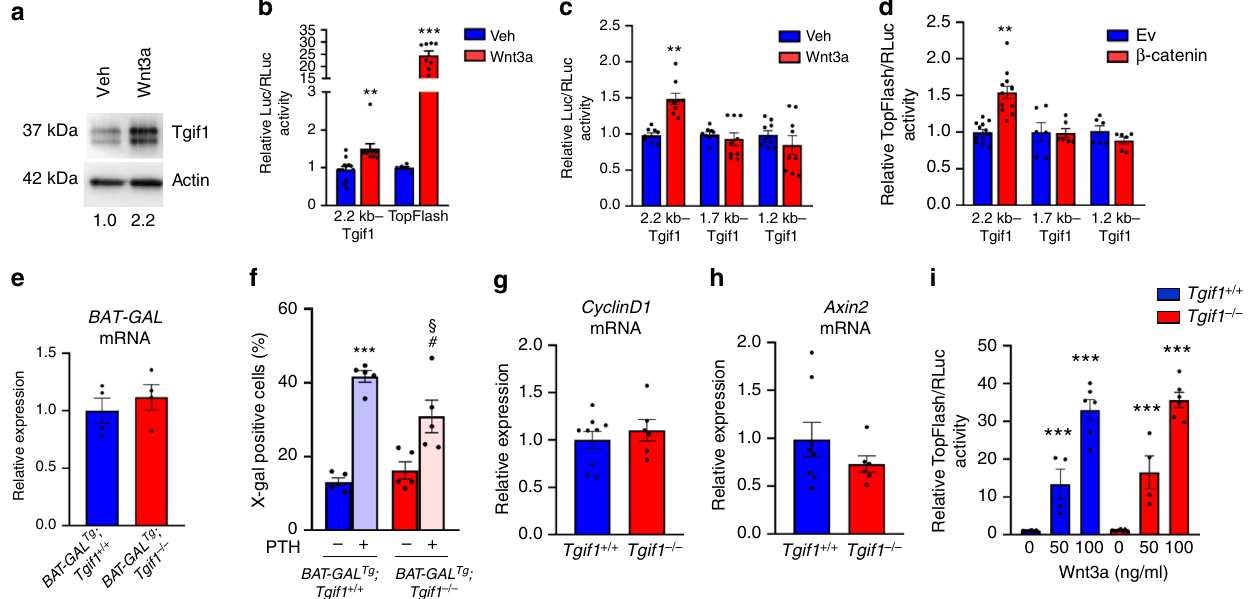
Fig. 3 Deletion of TG-interacting factor 1 (Tgif1) does not alter canonical Wnt signaling. a Immunoblot of Tgif1 protein expression in wild-type calvarial osteoblasts after stimulation with recombinant Wnt3a or vehicle (Veh) for 4 h. Immunoblot for Actin was used as a loading control. Normalized fold expression and molecular weight in kilo Dalton (kDa) are indicated (representative image of 4 experiments). b Luciferase assays in wild-type calvarial osteoblasts transfected with a 2.2 kb Tgif1 reporter construct or a Wnt-responsive TopFlash reporter plasmid and stimulated with Veh or Wnt3a for 24 h. c ST2 cells were transfected with a 2.2 kb Tgif1 reporter construct and different truncations thereof, and stimulated for 4 h with Veh or Wnt3a. d ST2 cells were co-transfected with empty vector (Ev) or β -catenin and the 2.2 kb Tgif1 reporter construct or truncated forms thereof. b – d ** p <0.01, *** p < 0.001 vs. Veh or Ev control. e Relative β -galactosidase ( BAT-GAL ) mRNA expression in tibiae of BAT-GAL Tg ;Tgif1 + / + and BAT-GAL Tg ;Tgif1 − / − mice ( N = 4, 4). f Quanti fi cation of the fraction of β -galactosidase-positive bone marrow stromal cells (BMSCs) obtained from BAT-GAL Tg ;Tgif1 + / + and BAT-GAL Tg ;Tgif1 − / − mice upon stimulation with parathyroid hormone (PTH) for 4 h ( N = 5, 5). *** p < 0.001 vs. BAT-GAL Tg ;Tgif1 + / + ;Veh, # p < 0.05 vs. BAT-GAL Tg ;Tgif1 − / − ; Veh, § p <0.05 vs. BAT-GAL Tg ;Tgif1 + / + ;PTH. g Relative mRNA expression of the Wnt pathway target genes CyclinD1 and h Axin2 in tibiae of 12-week-old male mice of the genotype Tgif1 + / + or Tgif1 − / − ( N = 8, 6). i Relative activation of the canonical Wnt pathway upon stimulation with increasing concentrations of recombinant Wnt3a in calvarial osteoblasts of the genotypes Tgif1 + / + and Tgif1 − / − quanti fi ed by a TopFlash reporter gene assay ( N = 6). *** p < 0.001 vs. cells of the same genotype without Wnt3a stimulation. Error bars represent the s.e.m. Two-tailed Student's t -test was used to compare two groups b – e , g